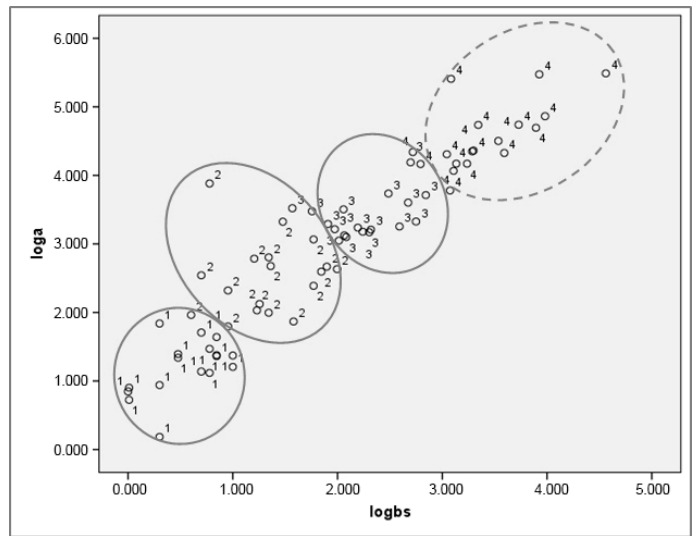
Figure 7. The determination of the rareness levels of the landscape types. loga, logarithmic value of the amount of area covered by the landscape type; logbs, logarithmic value of the number of landscape units.